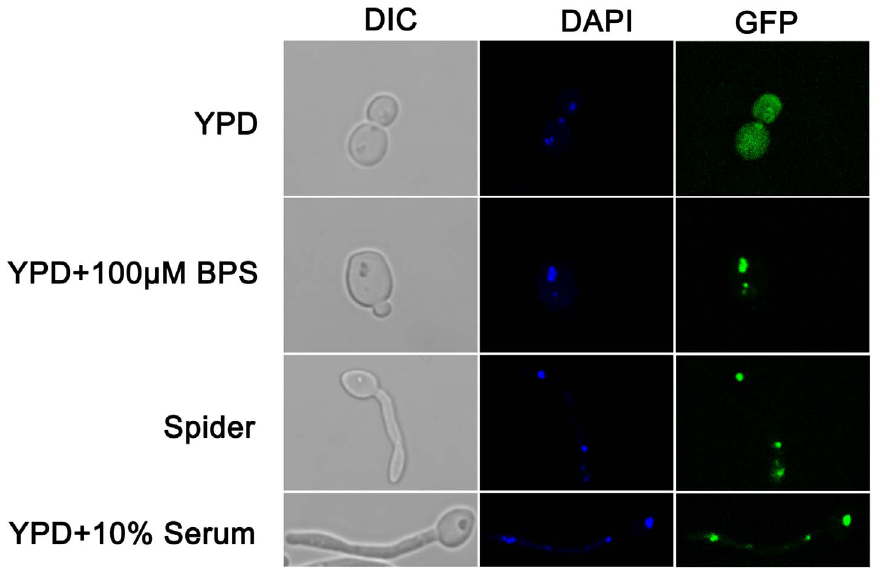
Figure 8. Environmental stimuli induce C.albicans Aft2 nuclear accumulation. Overnight cultures of the strain transformed with Aft2-GFP fusion plasmid were regrown to mid-exponential phase in YPD, YPD + 100 m M BPS, YPD + 10% serum and Spider medium, respectively. Cells were fixed with 3.7% formaldehyde, and then stained with 1 m g/ml 4’,6-diamidino-2-phenylindole (DAPI) for 10 min. The subcellular localization of Aft2 was determined by confocal laser scanning microscopy. DIC, Differential interference